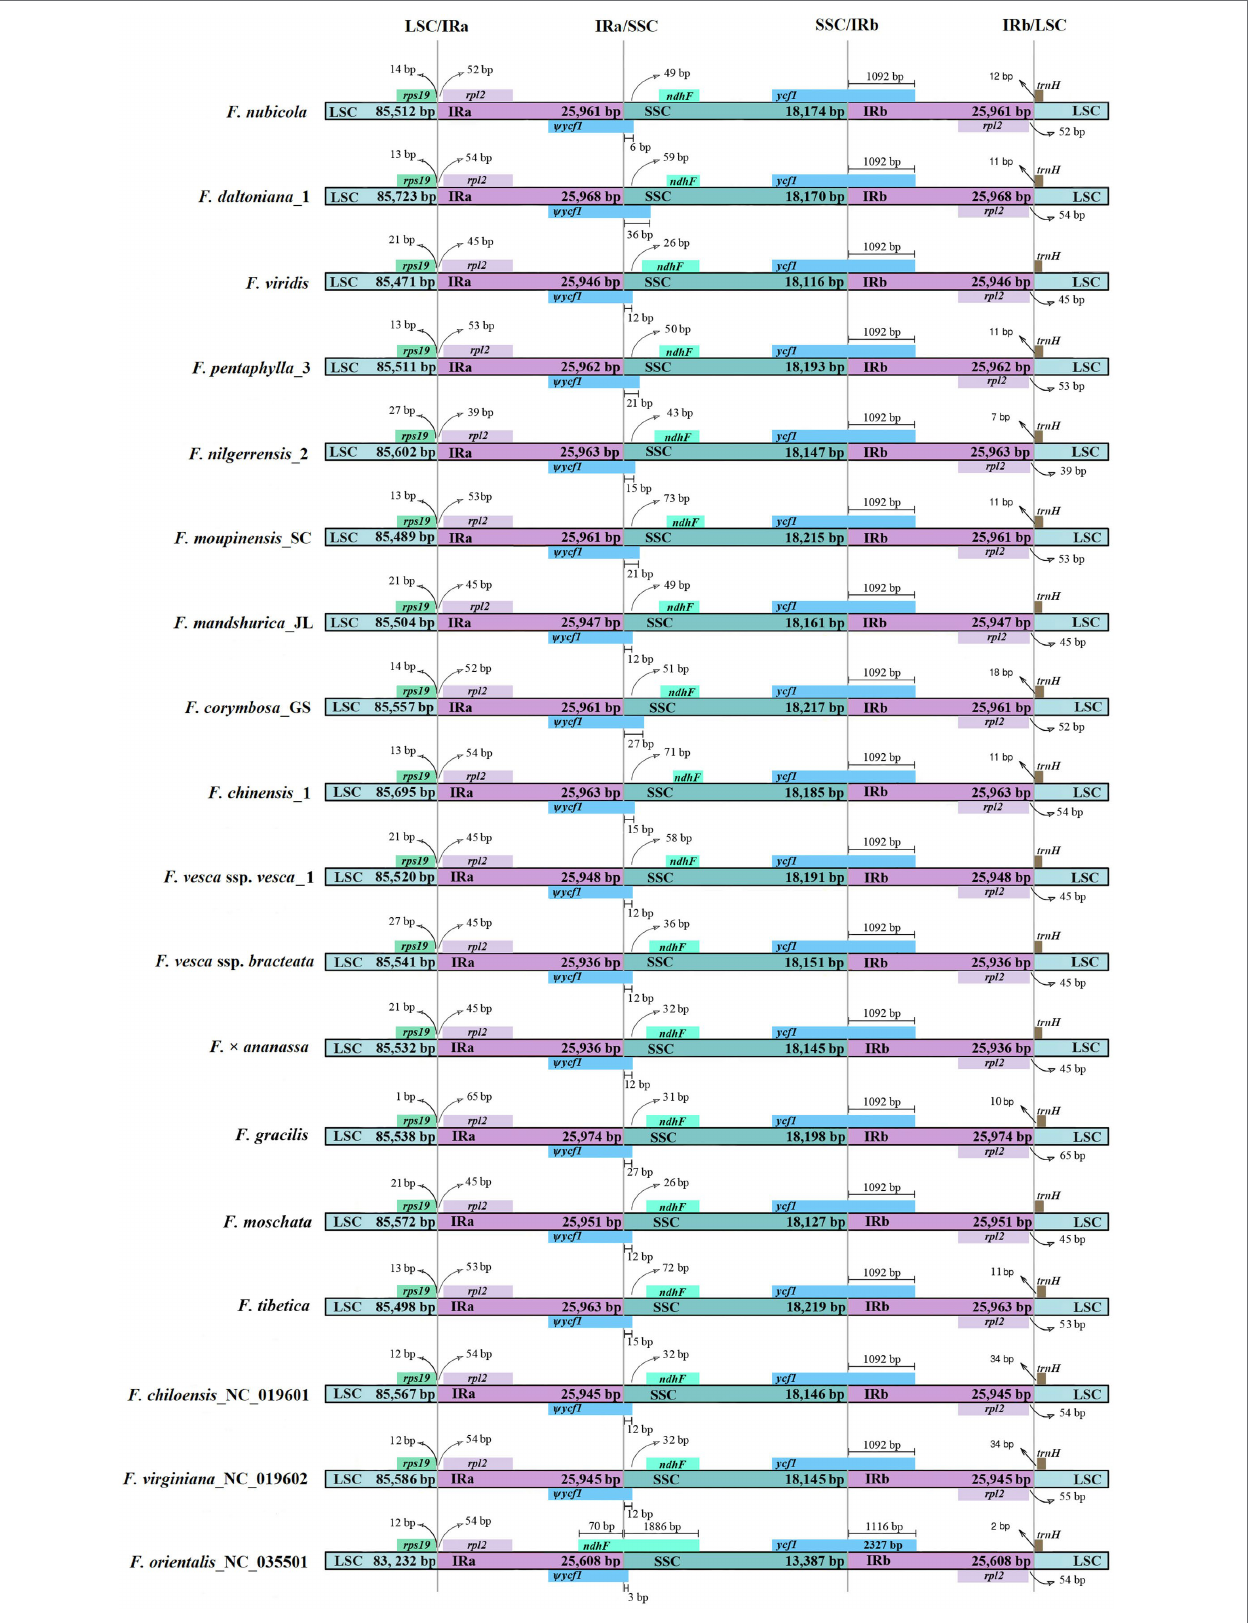
FIGURE 2 | Comparison of the LSC, SSC, and IR border regions among 18 Fragaria chloroplast genomes. Ѱ is used to indicate